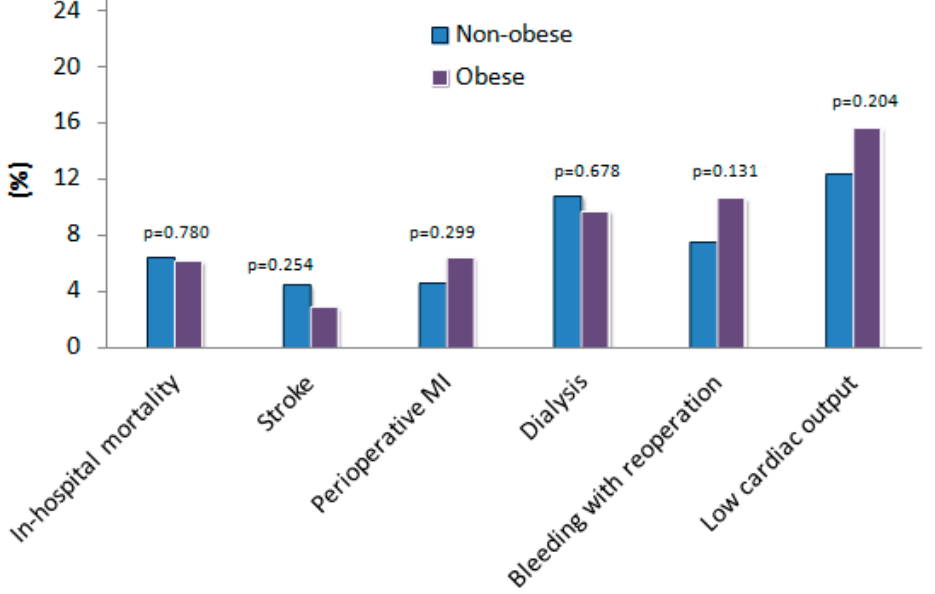
Figure 2. Primary and secondary outcomes of patients after coronary artery bypass grafting (CABG) surgery in acute coronary syndrome (ACS) after propensity score matching analysis. MI—myocardial infarction.